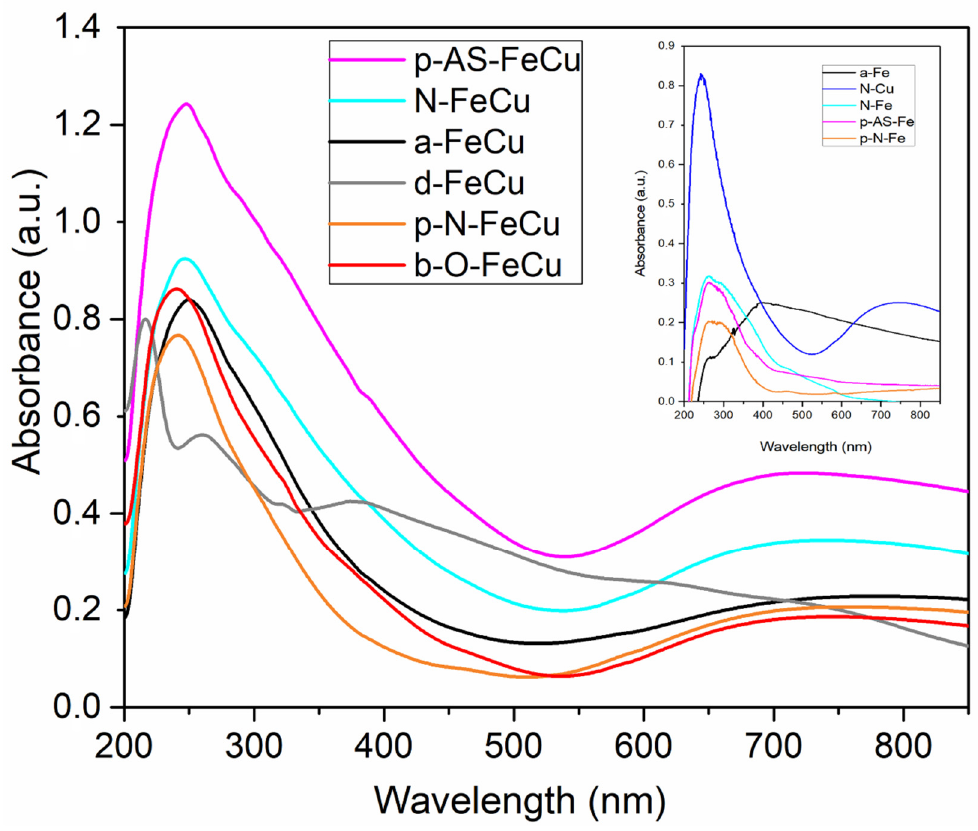
Figure 6. UV-Vis DRS (diffuse reflectance spectroscopy) spectra of FeCu samples and Fe alumina and Cu alumina samples in inserted graph.